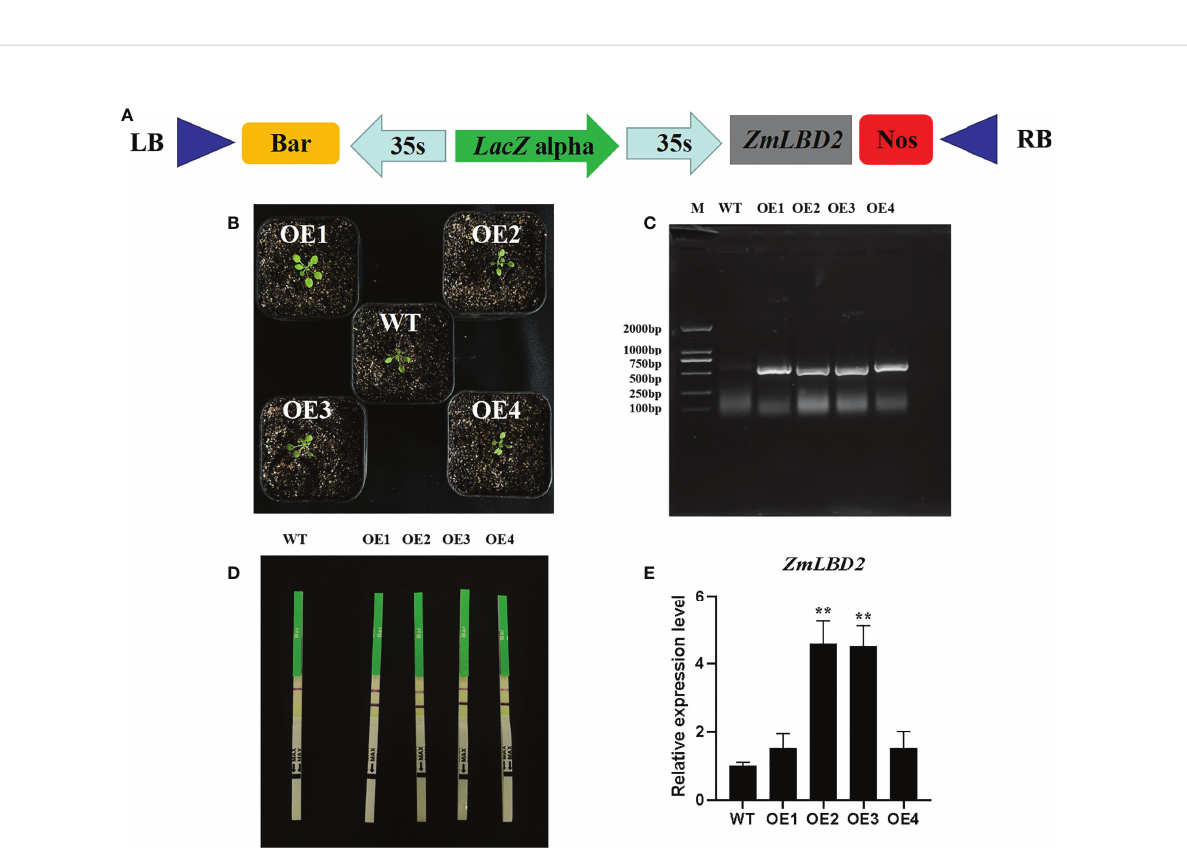
FIGURE 7 Identi fi cation of Arabidopsis overexpressing the ZmLBD2 gene. (A) Schematic of expression vectors pCAMBIA3301-ZmLBD2-Bar. (B) Transgenic Arabidopsis lines. (C) The PCR detection of the Bar gene in leaves of wild type (WT) and transgenic lines. (D) Rapid test strip analysis of the Bar gene in wild-type (WT) leaves and transgenic lines. (E) qRT-PCR analysis of the ZmLBD2 gene in leaves of wild type (WT) and transgenic lines. The expression level was normalized to that of Arabidopsis AtACTIN8. Data were expressed as the mean of triplicate values, and error represented the SD. The * and ** represents p < 0.05 and p < 0.01,